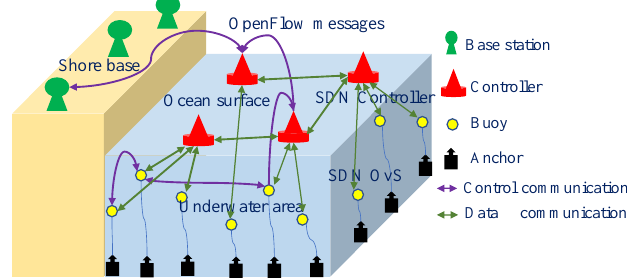
Figure 1. The FL-SDUAN model.